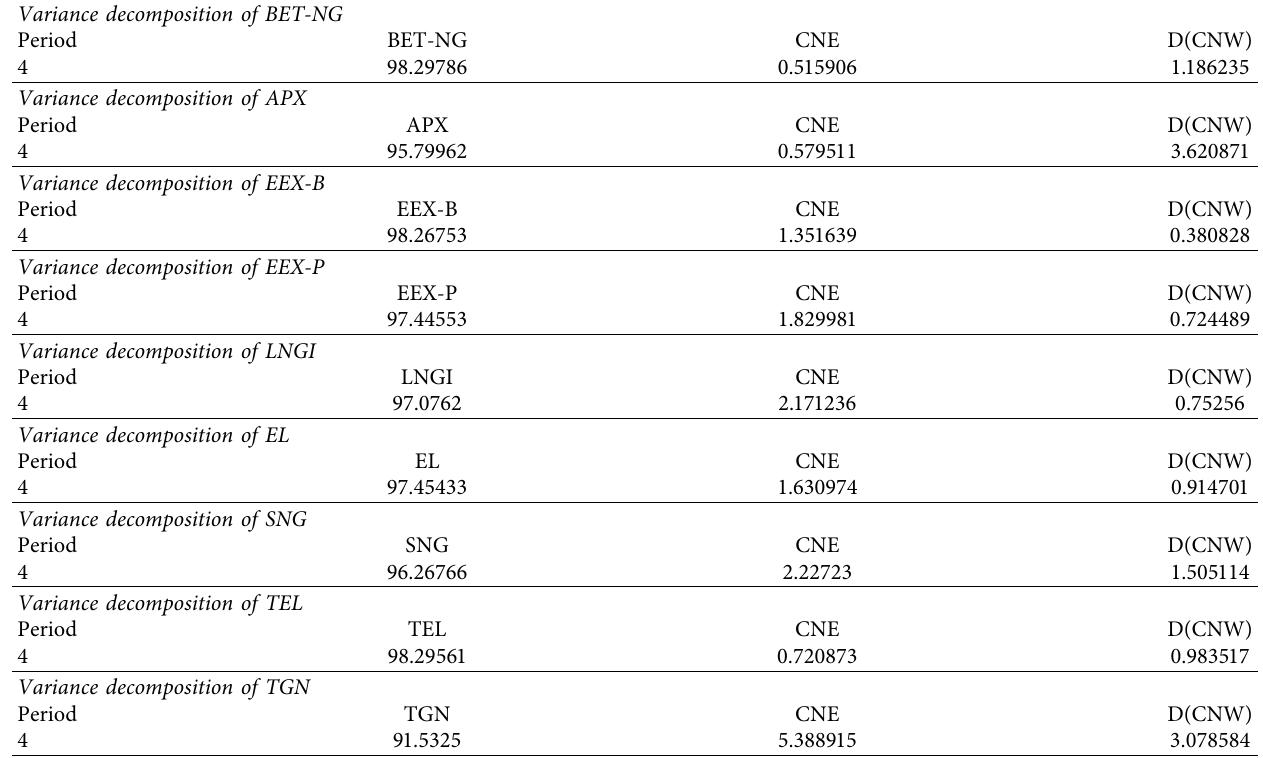
Table 12: The results of the variance